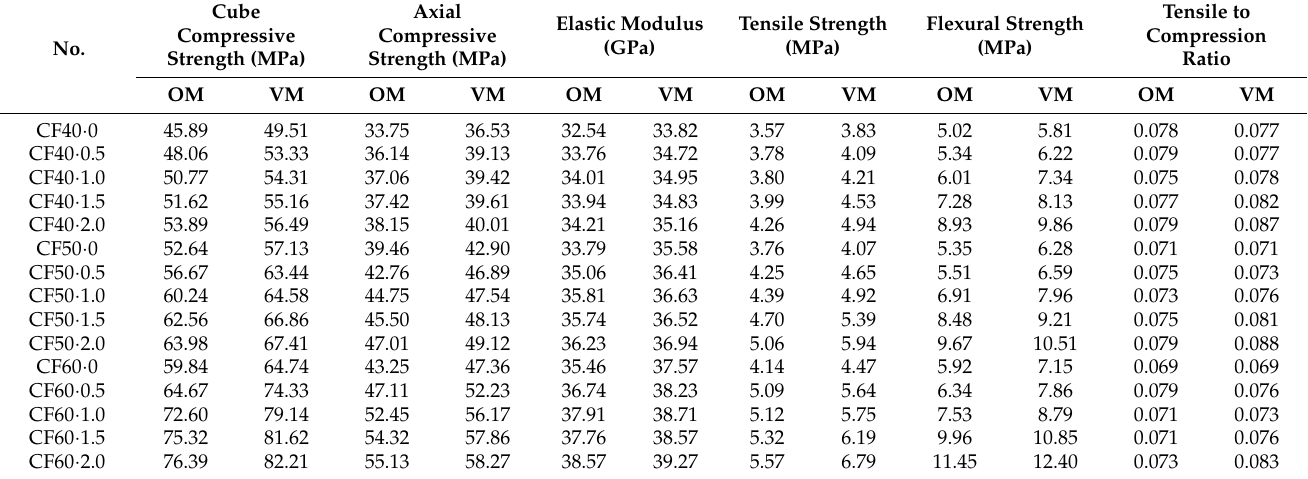
Table 5. Experimental results. OM (VM) refers to ordinary (vibration)